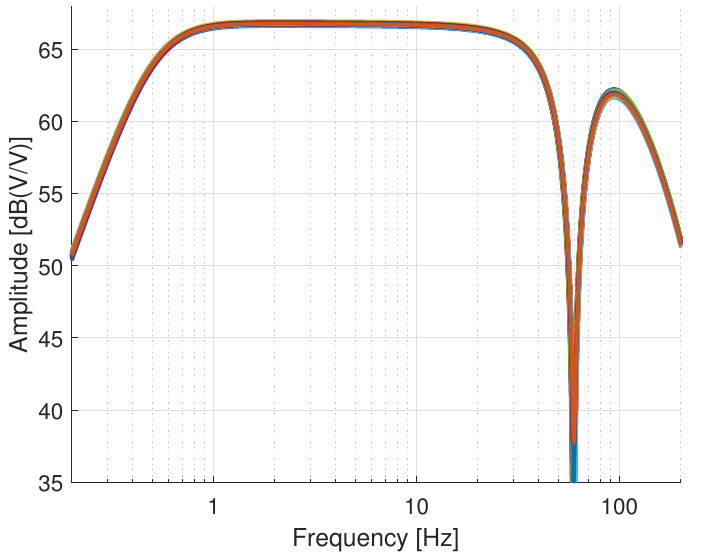
Figure 15. Magnitude response of the Monte Carlo simulation samples of the last stage of circuit 2. Each line plot represents a different Monte Carlo